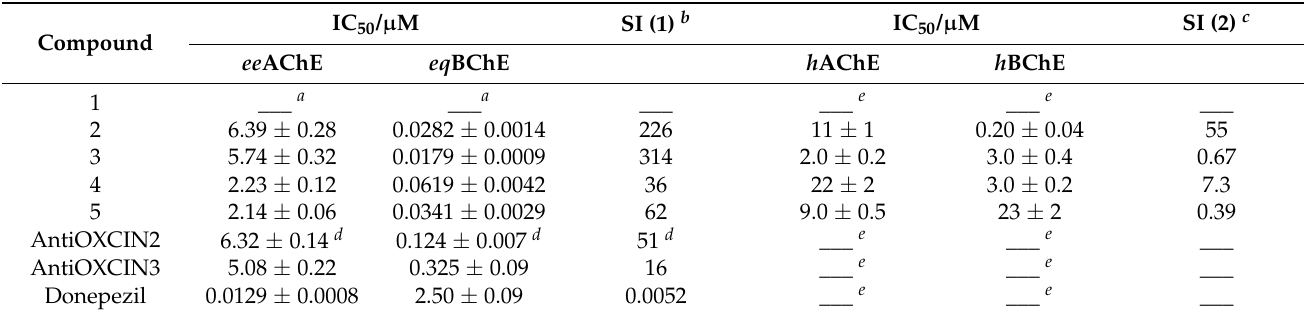
Table 2. Evaluation of ChE ( ee AChE, eq BChE, h AChE, h BChE) inhibitory activity of piperine (compound 1), compounds 2–5, AntiOXCIN2 and AntiOXCIN3 and reference